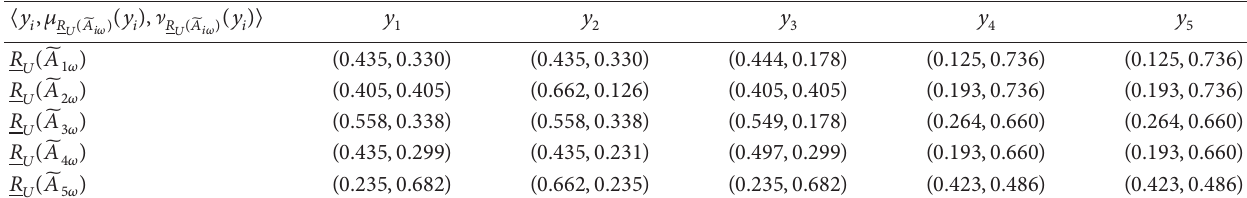
Table 4: The lower approximations of weighted Atanassov’s intuitionistic fuzzy sets.